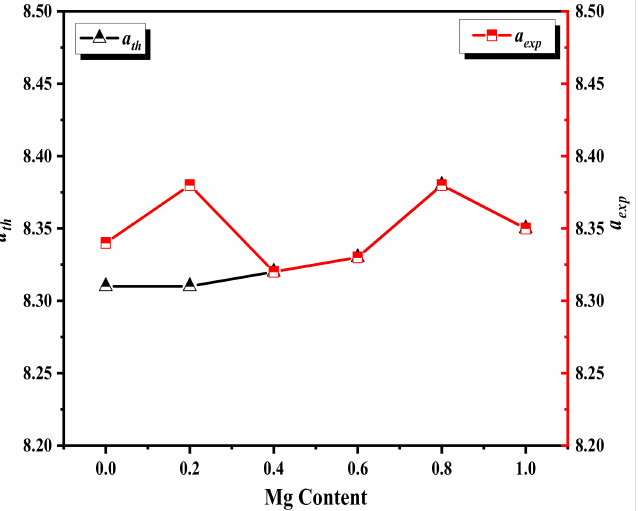
Figure 2. a exp and a th vs. Mg content (x = 0, 0.2, 0.6, 0.8, and 1) for Ni + 2